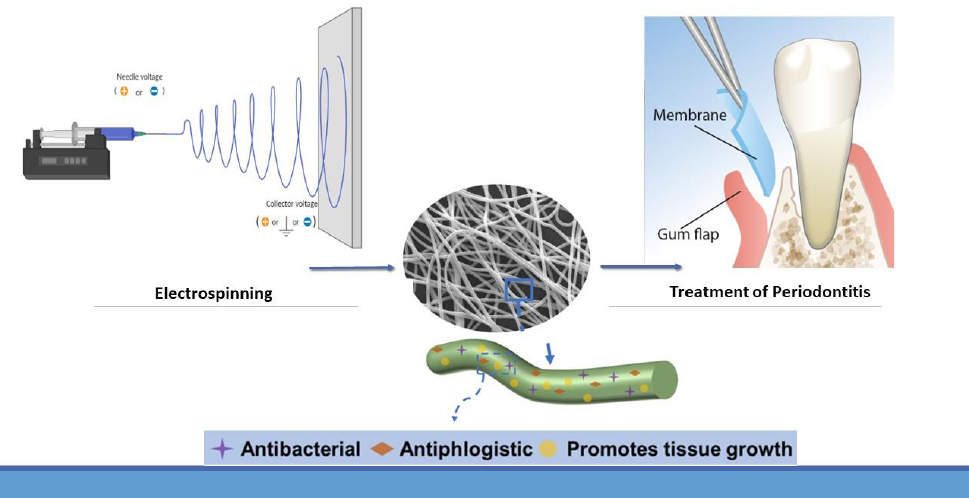
Figure 3. The procedure of electrospinning to make nanofibers. Each nanofiber has antibacterial and antiphlogistic activity and promotes tissue growth. Nanofibers are assembled in membranes and then applied to the periodontitis-affected site.